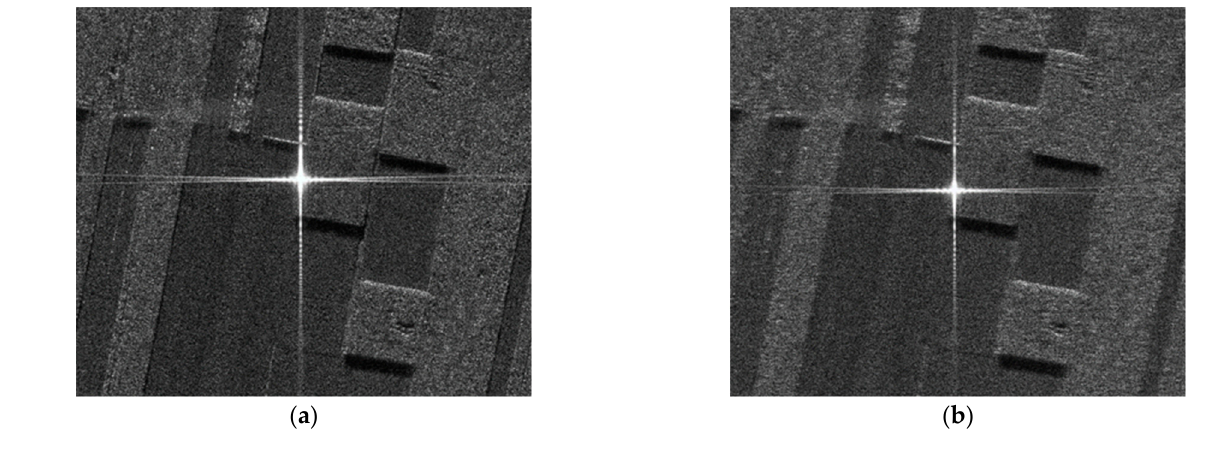
Figure 6. Absolute value local SAR image of a point target. ( a ) Reference channel absolute value SAR image; ( b ) imbalance channel absolute value SAR image. Table 4. Amplitude bias estimation of multiple-channels SAR.